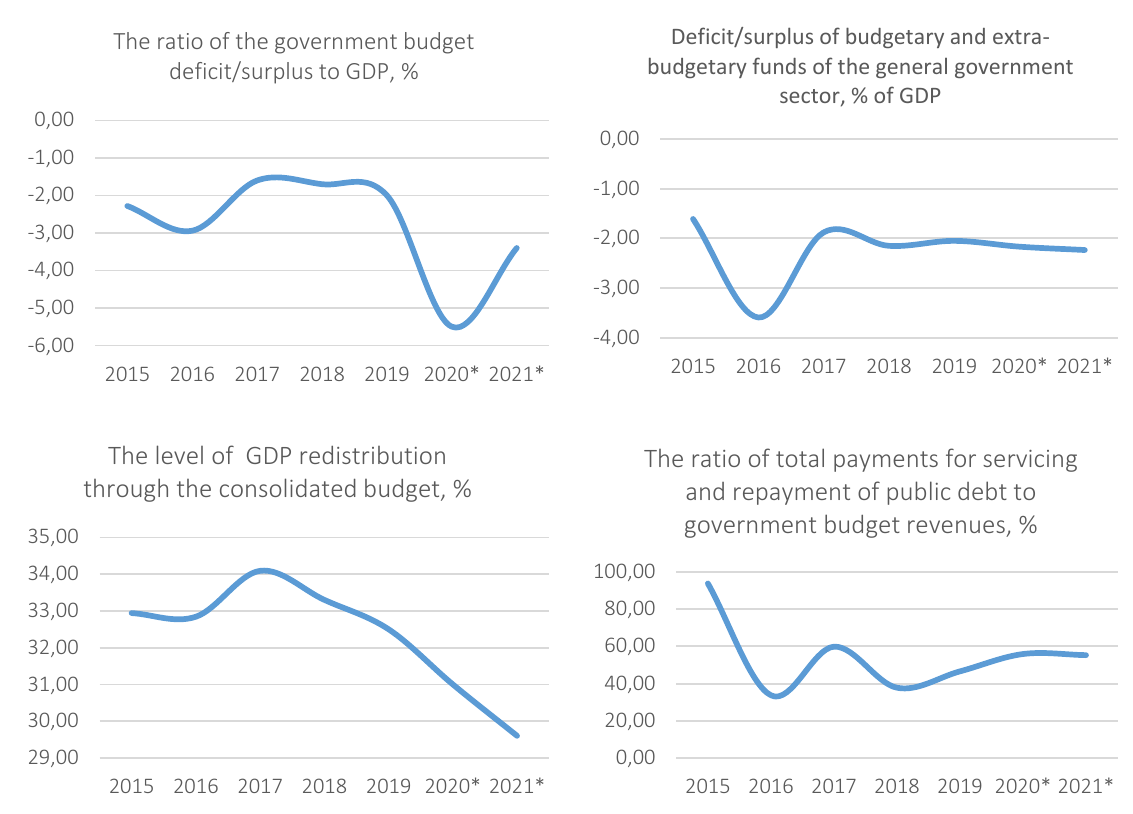
Figure 2. Actual (2015–2019) and forecast (2020–2021) values of Ukraine’s budget security indicators